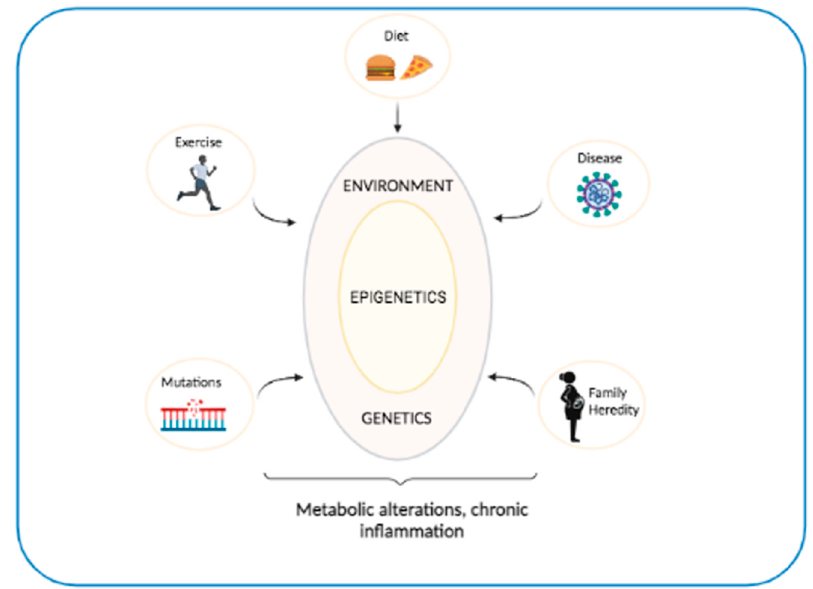
Figure 2. The role of genes and environment in T2D and OB. The interactions between environmental factors and genetic predisposition play a critical role in affecting metabolic processes and promoting chronic inflammation, which leads to severe diseases such as T2D and